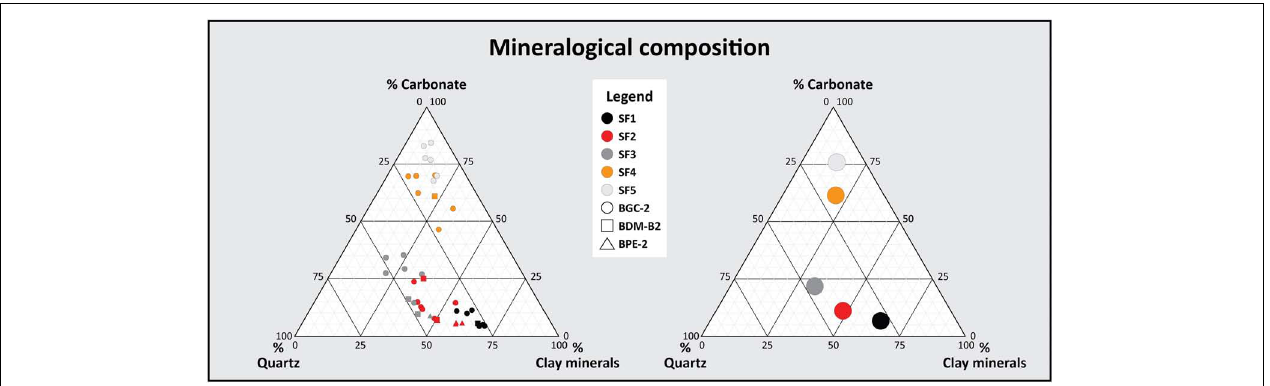
FIGURE 7 | Typical mineralogical composition of the five subfacies types. The left graph displays the mineralogical composition (wt%) of 41 samples from Mont Terri (BGC-2, BDM-B2, and BPE-2 drill cores), and the right graph shows the average composition for each subfacies type. Carbonates include calcite, dolomite, ankerite, and siderite; clay minerals are not distinguished. They include kaolinite, illite, illite-smectite mixed layers, chlorite, as well as muscovite. Sum contents of the three mineral groups (carbonates, quartz, and clay minerals) are normalized to 100%; further minor components are not